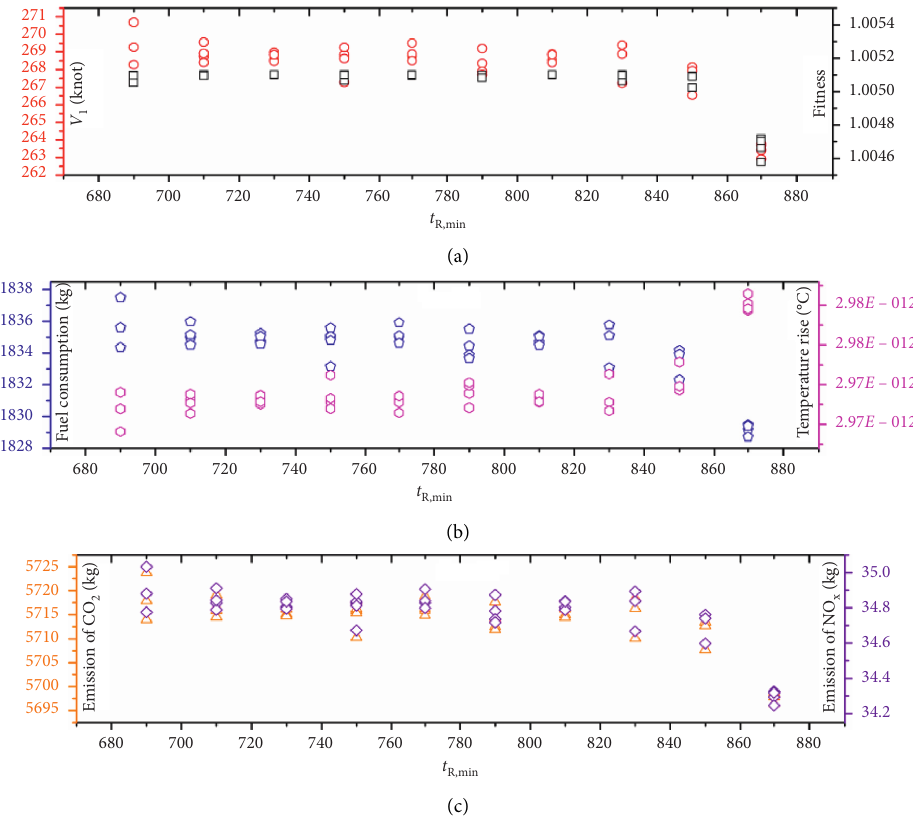
Figure 13: Effect of t R, min on optimization